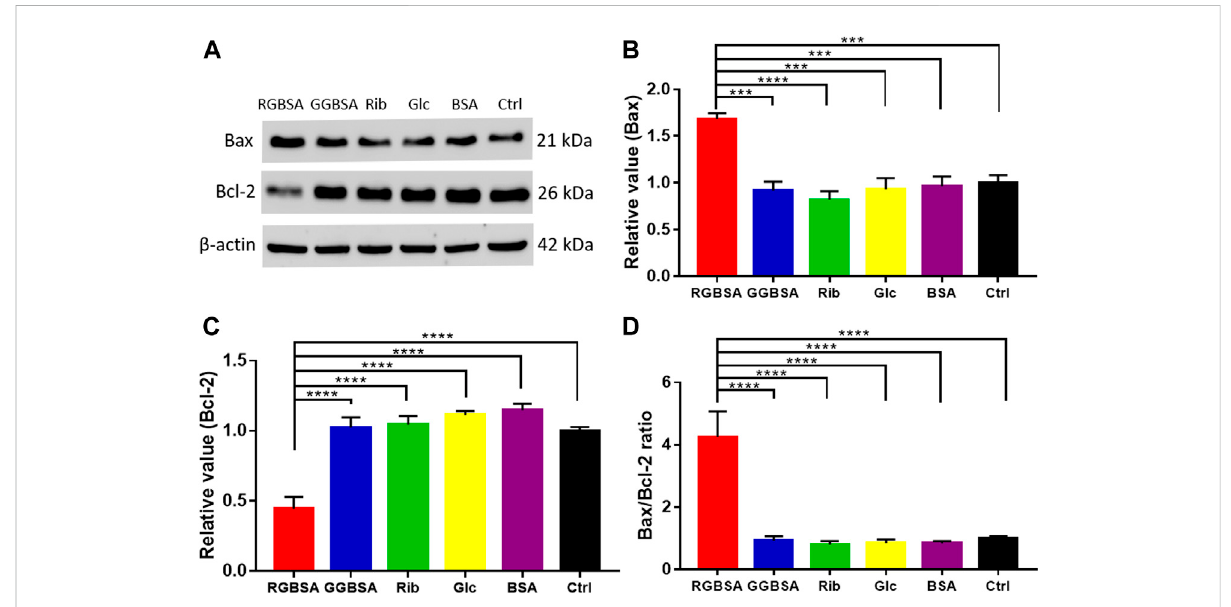
FIGURE 4 Riboglycated BSA regulates Bax and Bcl-2 proteins in SH-SY5Y cells. Experimental conditions were the same as in Figures 3C – H. The levels of Bax and Bcl-2 were determined by Western blot analysis (A) . β -actin was used as the loading control. Quanti fi cation results are shown in (B,C) .